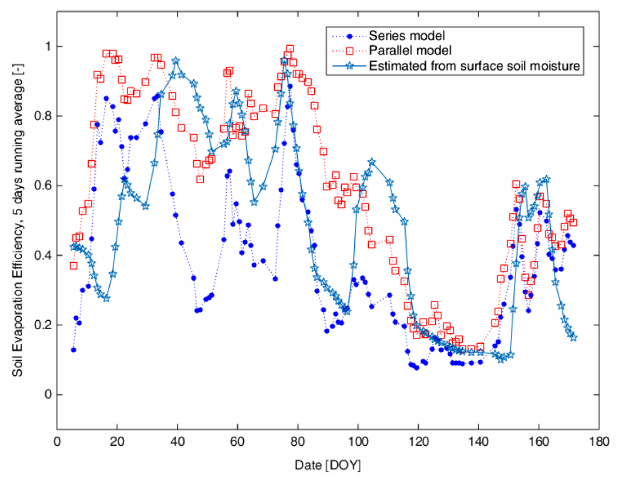
Figure 11. Same as Fig. 10, for the irrigated wheat